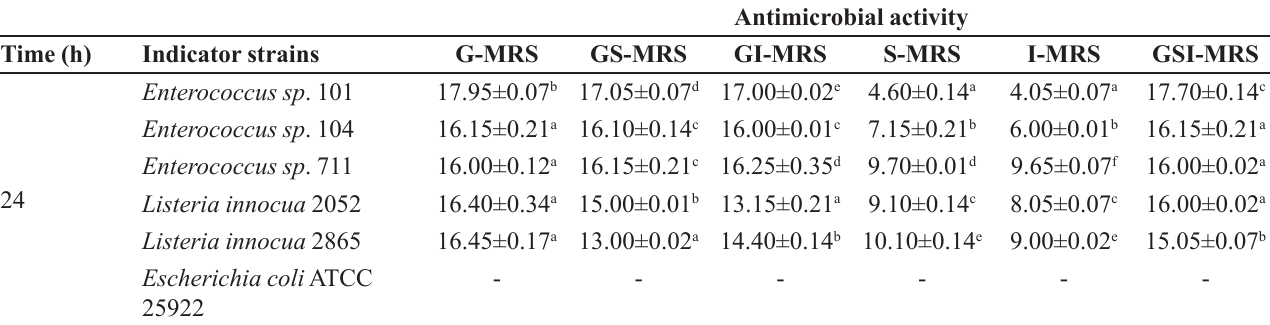
TABLE II - Antimicrobial activity (mm) of bacteriocin extract produced by P. pentosaceus ATCC 43200 cultivated in different media and collected at 24 h. The assays were performed on BHI ( Enterococcus and Listeria ) and TSB ( E. coli ) agar-media